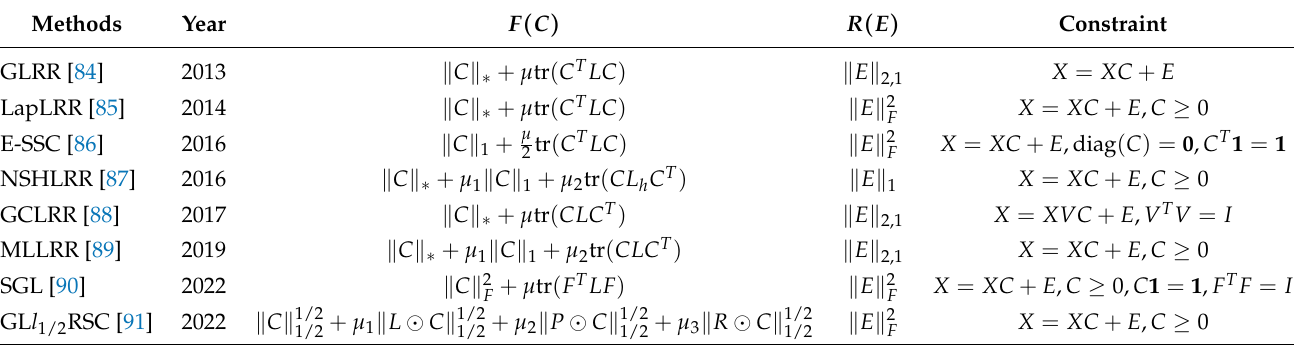
Table 5. The comparison of classical graph-regularized SC